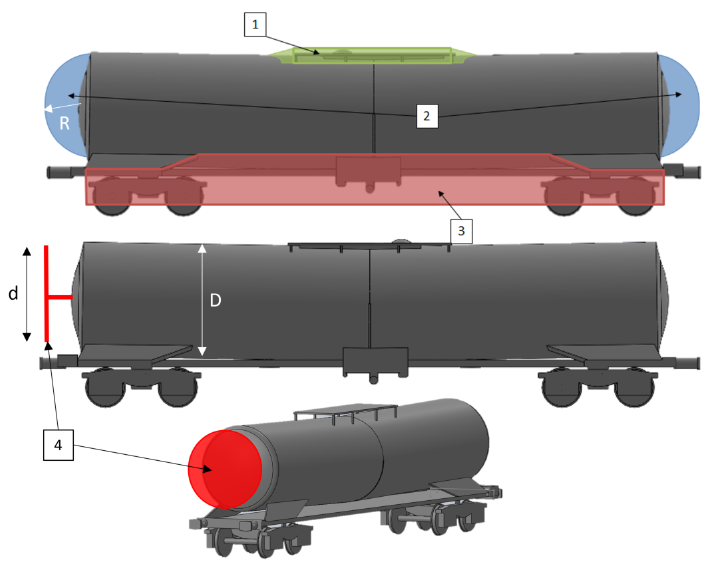
Figure 2. Modifications applied to the tank wagon. 1: Fairing of platform; 2: face radius; 3: side skirts; 4: inter-wagon